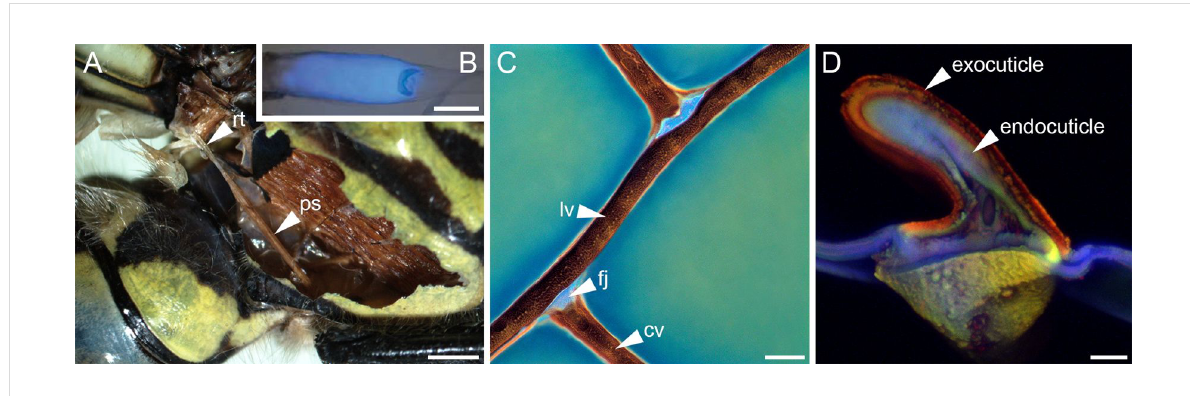
Figure 5: Resilin in flight systems of dragonflies. (A) Stereomicrograph depicting a resilin-bearing tendon (rt) of a pleuro-subalar muscle (ps) of the southern hawker ( Aeshna cyanea ). (B) Overlay of a bright-field micrograph and a wide-field fluorescence micrograph showing autofluorescence (blue) exhibited by resilin in a tendon of the genus Zyxomma . (C) Flexible wing vein joints (fj) joining cross veins (cv) to a longitudinal vein (lv) in a wing of the vagrant darter ( Sympetrum vulgatum ). (D) Cross section through a wing vein of S. vulgatum , revealing sclerotised exocuticle and resilin-bearing endocuticle. (C, D) Confocal laser scanning micrographs (maximum intensity projections) showing overlays of different autofluorescences exhibited by the exoskeletons. Structures with large proportions of resilin are shown in blue. Scale bars = 1 mm (A), 100 µm (B), 40 µm (C), 10 µm (D). (B) Adapted with permission from [13], copyright 2005 Nature Publishing Group. (D) Adapted with permission from [79], copyright 2015 John Wiley and